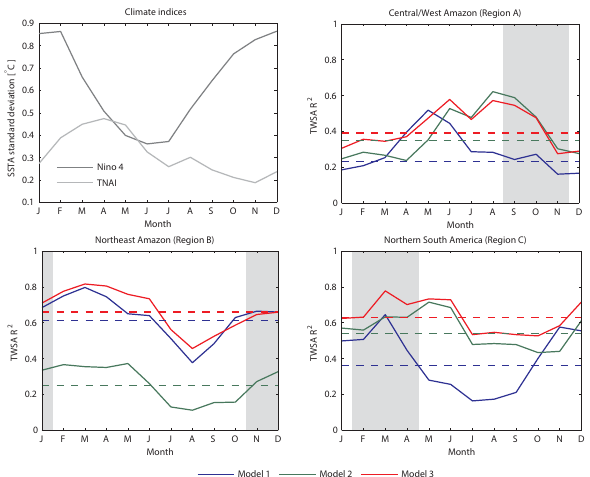
Figure 6. RMSE versus prescribed minimum lead time for the three models, averaged over each of the three regions delineated in Fig. 1a. Dashed lines bound the 95% confidence intervals within which the models either forced by Niño 4 (model 1) or TNAI (model 2) are statistically different from the combined model (model 3). The vertical dotted line represents the minimum lead time that was used in the previous figures. The corresponding R 2 model perfor- mance metric is shown in Fig. S4 in the